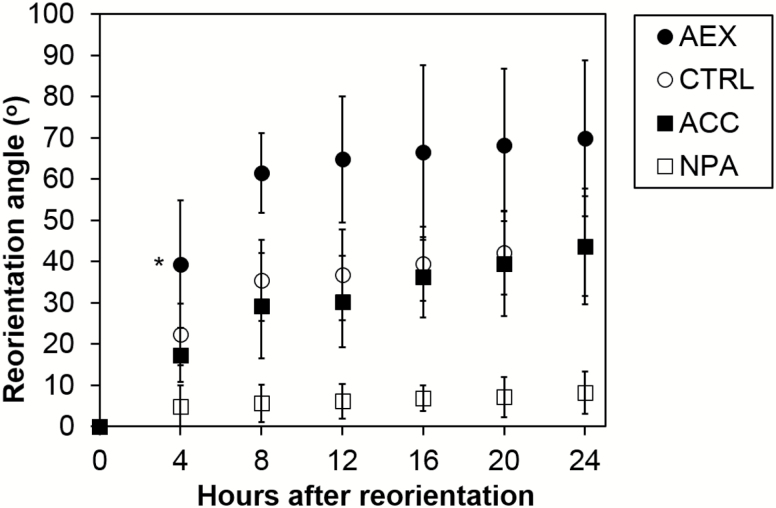
Response of etiolated Col-0 seedlings after growth and reorientation on vertically standing plates. Seedlings were grown in the presence of 0.05% DMSO (CTRL), 10 µM ACC, 50 µM AEX or 10 µM NPA. All treatments contained 0.05% DMSO. On day 2 after germination, plates were rotated by 90°, plants laying close to the horizontal axis were analysed, and the average reorientation angle of the hypocotyl was calculated. Ninety degrees corresponds with the new direction of the gravity vector. Data are presented as means±SD. Reorientation angle of AEX-treated seedlings at time point 4 h was compared with CTRL seedlings by means of Wilcoxon’s rank sum test (*P<0.05; 8>n>10). Experiments were performed twice with highly similar results; results of a representative experiment are shown. Results of a reorientation assay on selected mutants are shown in Supplementary Fig. S6.